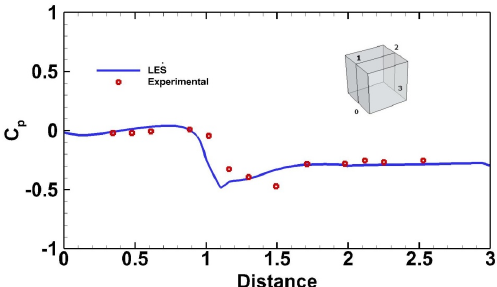
Figure 2. Pressure coefficient around the Silsoe Cube situated in the building array of Case 1, with “-” as the present results and with “o” as the measurements from the King, Gough [45]